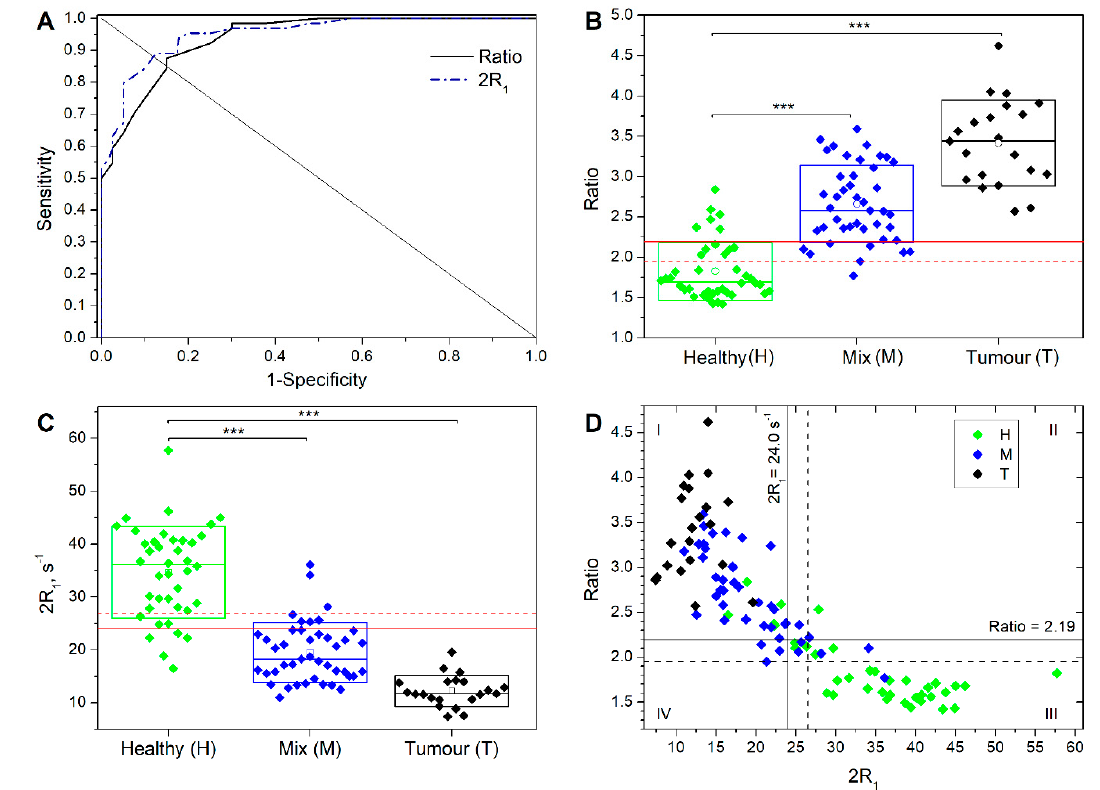
Figure 3. ( A ) ROC curve for the dataset describing the sensitivity vs. 1 minus specificity for different Ratio and 2R 1 cut-off values plotted against the equal error rate line where there is an equal probability of miss-classifying a positive or negative sample. ( B,C ) Box chart of the Ratio and 2R 1 values calculated for the 104 investigated tissue samples. The box is determined by the mean ± SD. The line inside each box represents the 50th percentile (median). The thick line represents the cut-off value (see text). Statistical significance was determined by Student’s t -test (*** p < 0.01). ( D ) The Ratio value as a function of the 2R 1 value for all the 104 samples, labelled by colour as H, M, and T.